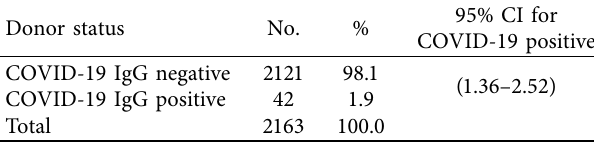
Table 1: COVID-19 IgG positive status among blood donors.